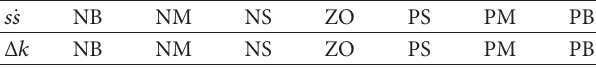
Table 2: Fuzzy table of output.